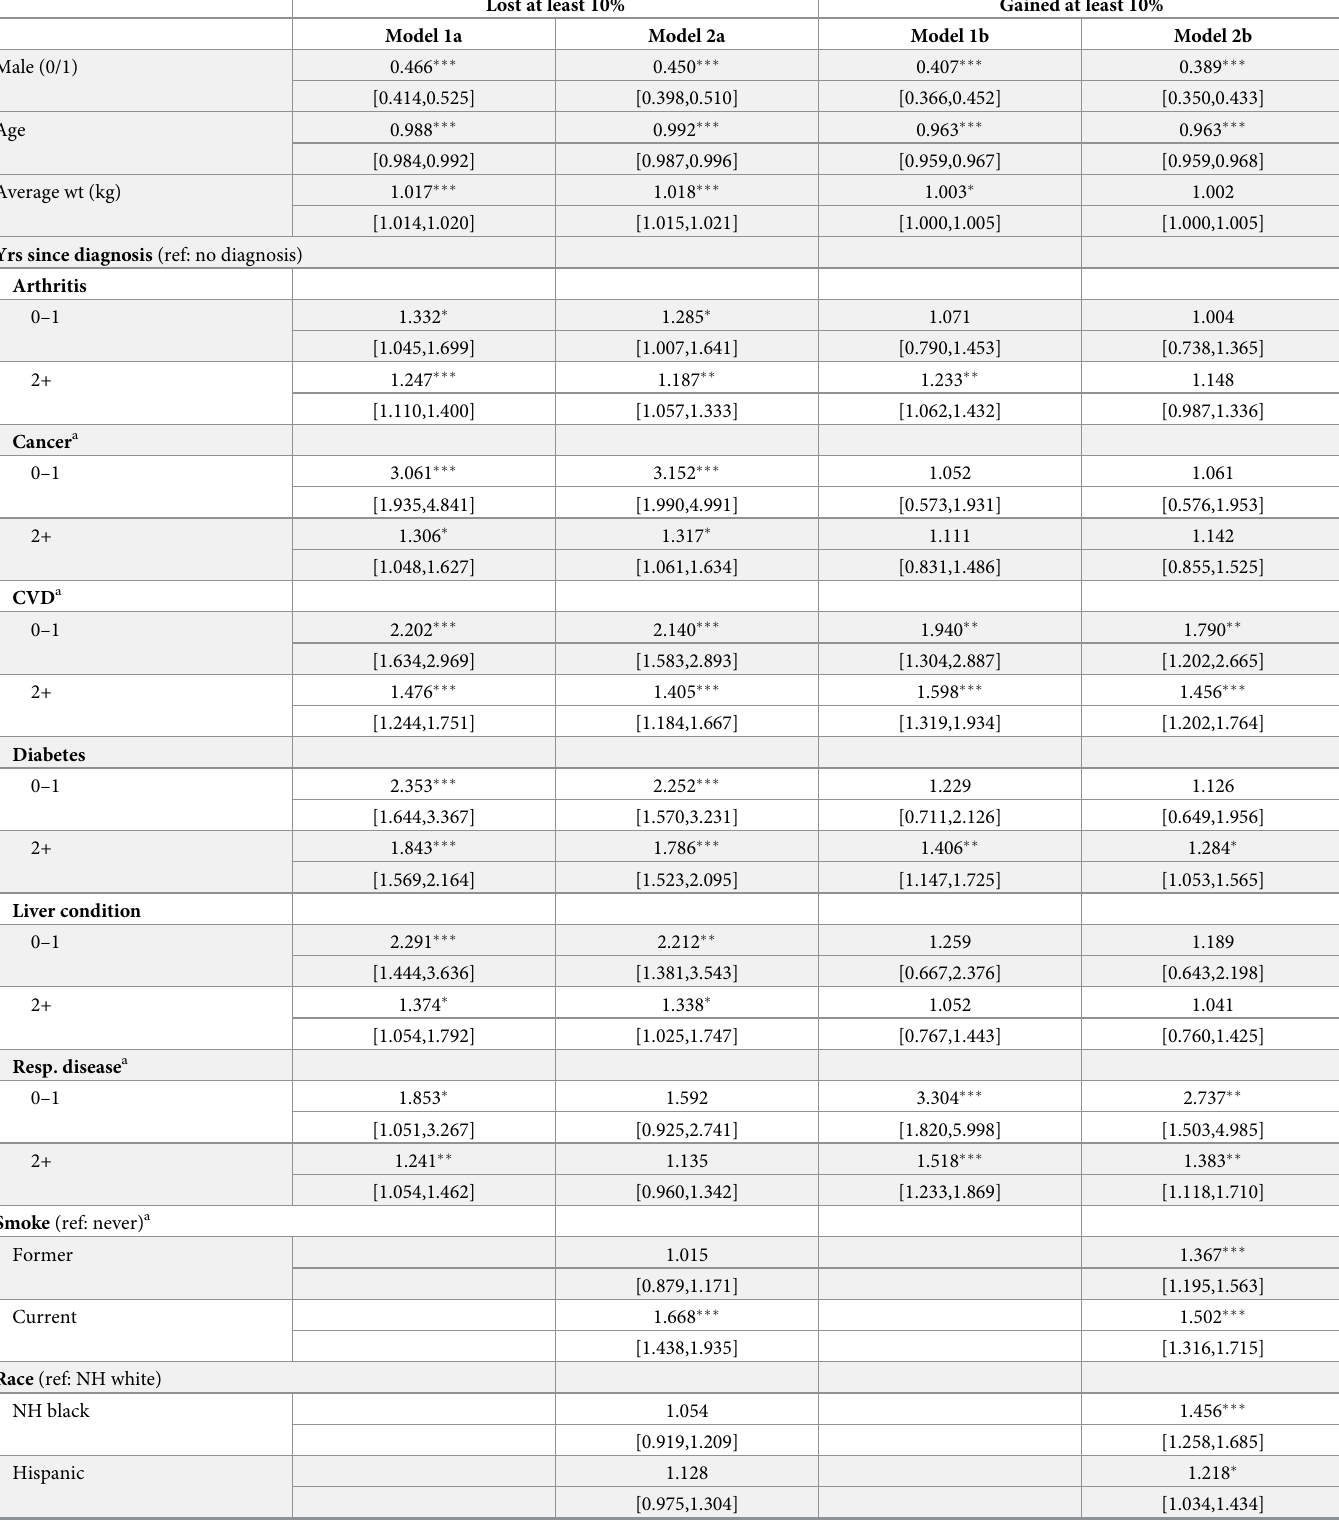
Table 4. Odds ratios from multinomial logistic regressions predicting 10% weight change in the last year (reference category is no change of at least 10%). Adults 30+, NHANES 1999–2014. 95% confidence interval in brackets. N =